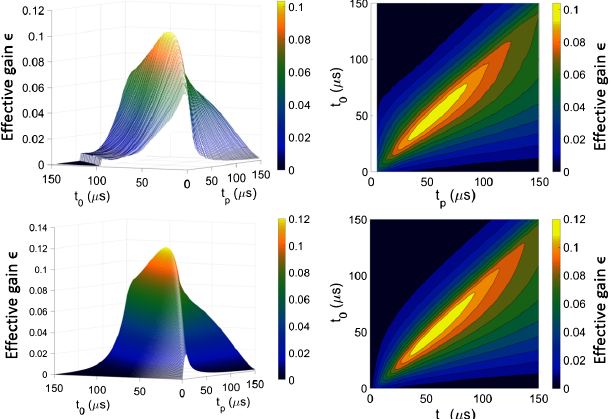
FIG. 7. Top: Experimental effective gains versus t p and t 0 for t 10 μ s. Bottom: Simulated effective gains versus t e ¼ 10 μ s, F ¼ 23 000 and a steady state gain of t e ¼